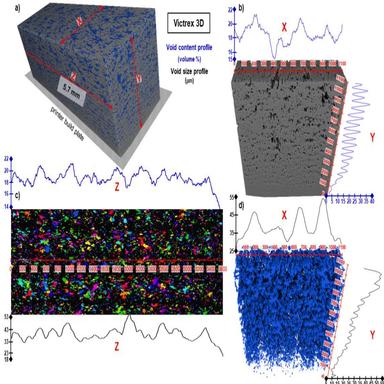
Victrex printed a) 3D visualisation of the sample's tomogram image showing X, Y, and Z-axis direction and, in blue, segmented voids; b) void content profiles for X and Y directions plotted against respective image slices scale bar and 3D visualisation of a subset segmented image showing fibres and resin (grey) with voids set 100 % transparent; c) void content and size profiles along the sample printing direction (Z) plotted against longitudinal image slices scale bar and central 2D Label image showing indiv